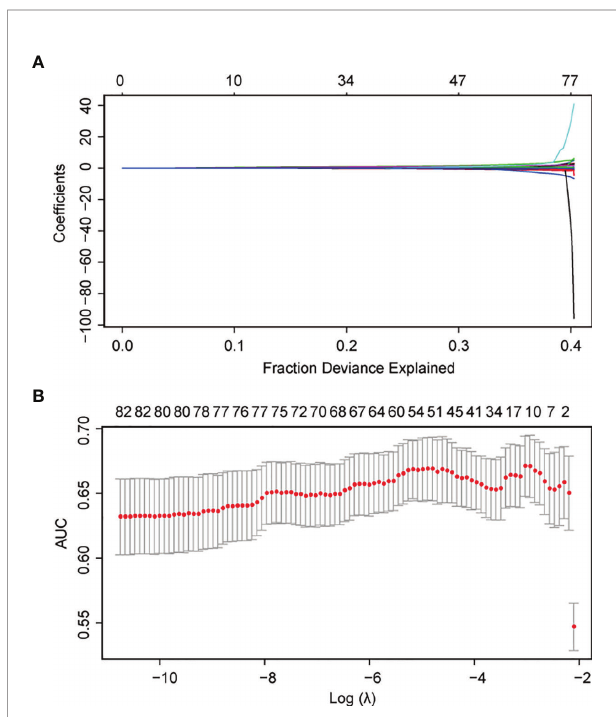
FIGURE 1 | LASSO regression analysis using 10-fold cross-validation. AUC, area under the